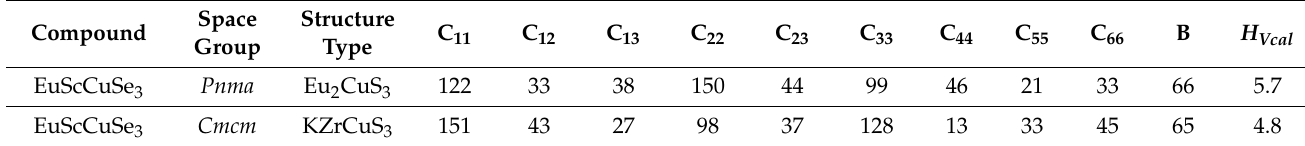
Table 4. Elastic constants (GPa) for EuScCuSe 3 .